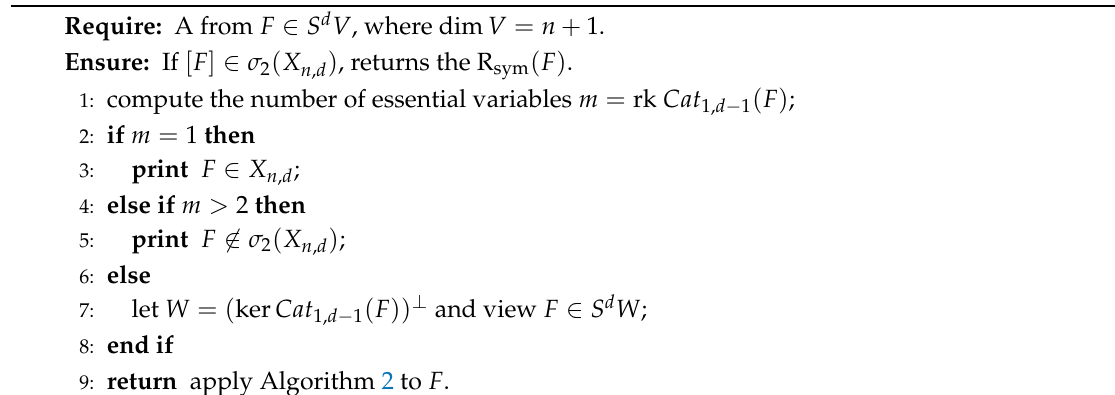
Algorithm 3: An algorithm to compute the symmetric-rank of an element lying on σ 2 ( X n , d )